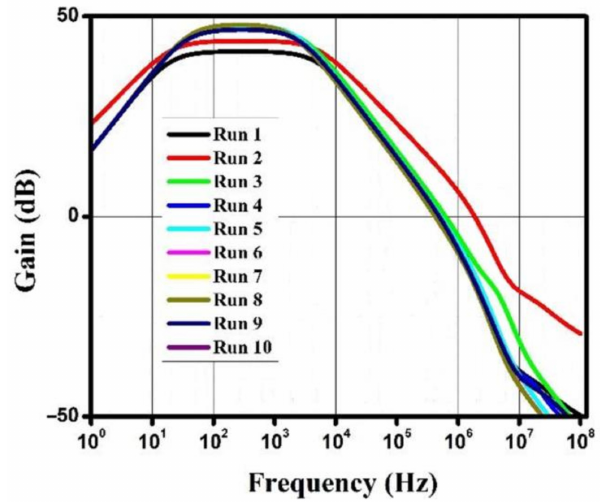
Figure 10. Gain vs. frequency plot for circuits designed after results from ANN-assisted goal attainment method.